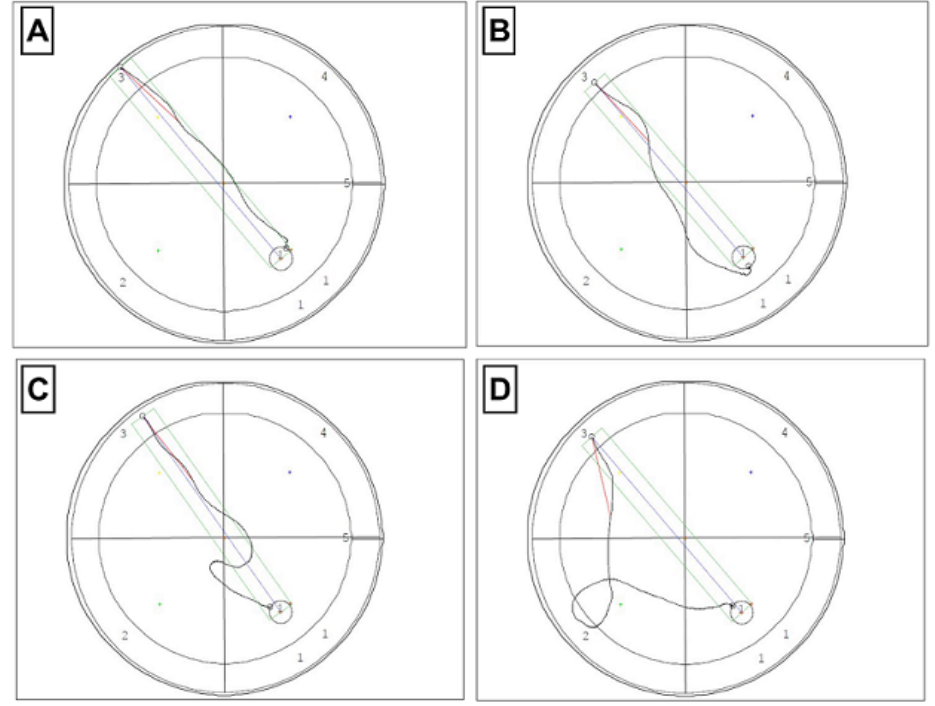
Figure 5. The recordings of the paths of directional flow in the W-channel for one selected animal from each study group. ( A ) control group; ( B ) TPB (Topinambur); ( C ) INU (Inulin); ( D ) FLU